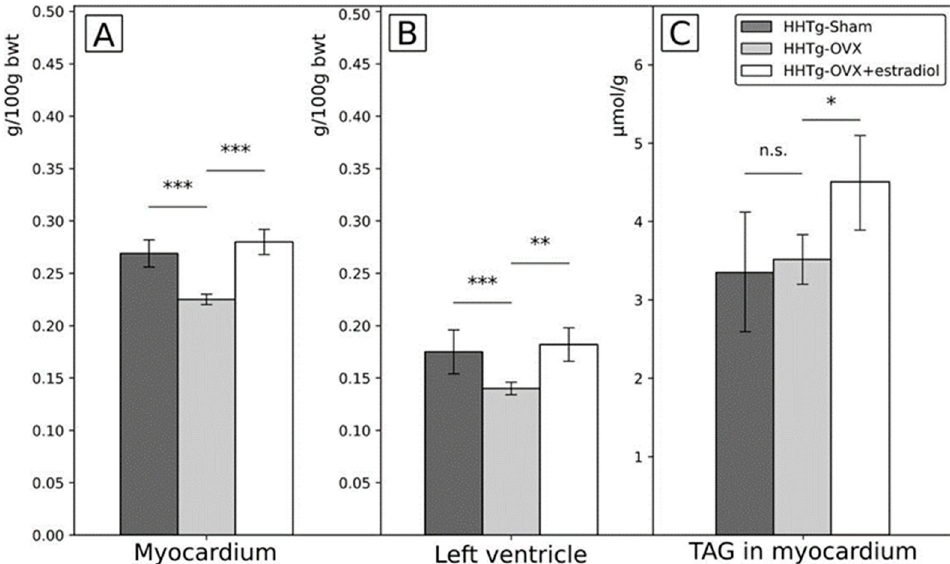
Figure 3. Differences in the relative weight of myocardium ( A ) and the left ventricle ( B) and triglycerides content of the myocardium ( C ) after ovariectomy and estradiol substitution in HHTg rats. Legend: HHTg: hereditary hypetriglyceridemic; HHTg-Sham: sham group, n = 5; HHTg-OVX: Ovx: ovariectomy ( n = 6); HHTg-OVX + estradiol: ovariectomy followed by estradiol substitution ( n = 6). Data are expressed as mean ± SD and evaluated by one-way ANOVA and Fisher LSD post-hoc test; n.s.: nonsignificant, * p < 0.05, ** p < 0.01, *** p < 0.001. Table 1. Differences after Ovariectomy and Estradiol Substitution in Hereditary Hypertriglyceridemic Rats in the Relative Weight and Lipid Content of Extracardiac Tissues and Organs. p Sham Ovx Ovx + Estradiol n = 5 n = 6 n = 6 Ovx + E vs.